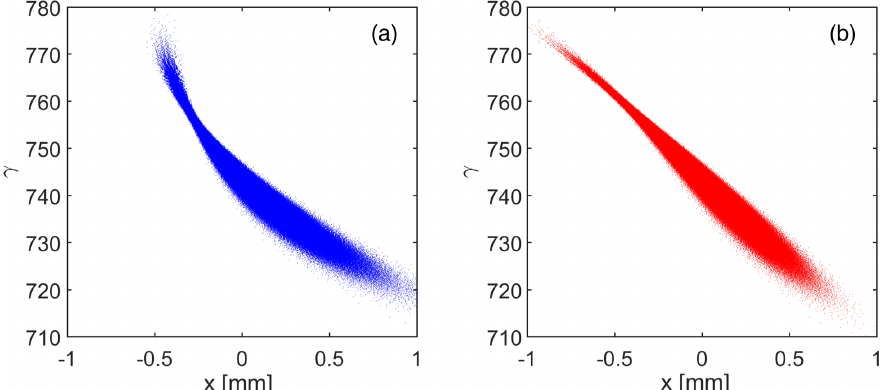
FIG. 4. Dispersion distributions at the entrance of the TGU undulator. (a) Nonlinear distribution of x − γ phase space through the focusing system including dipole and quadrupoles. (b) Quasilinear distribution of x − γ phase space with additional sextupoles.